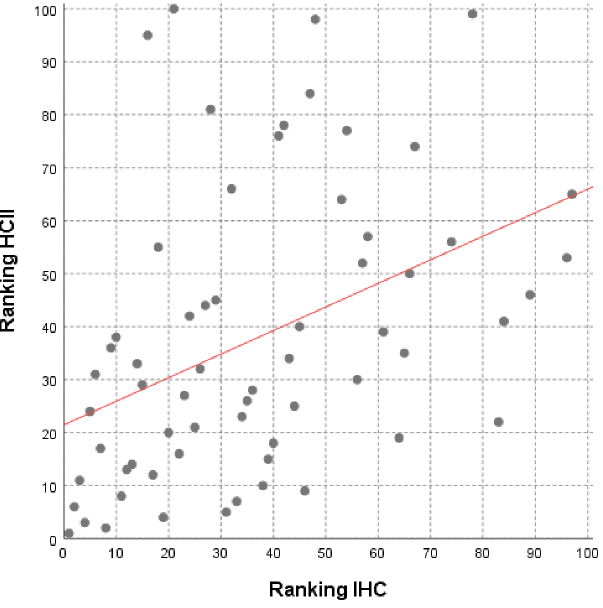
Figure 14. Scatterplot of the words in common between the two conferences up to the hundredth position of their rankings.